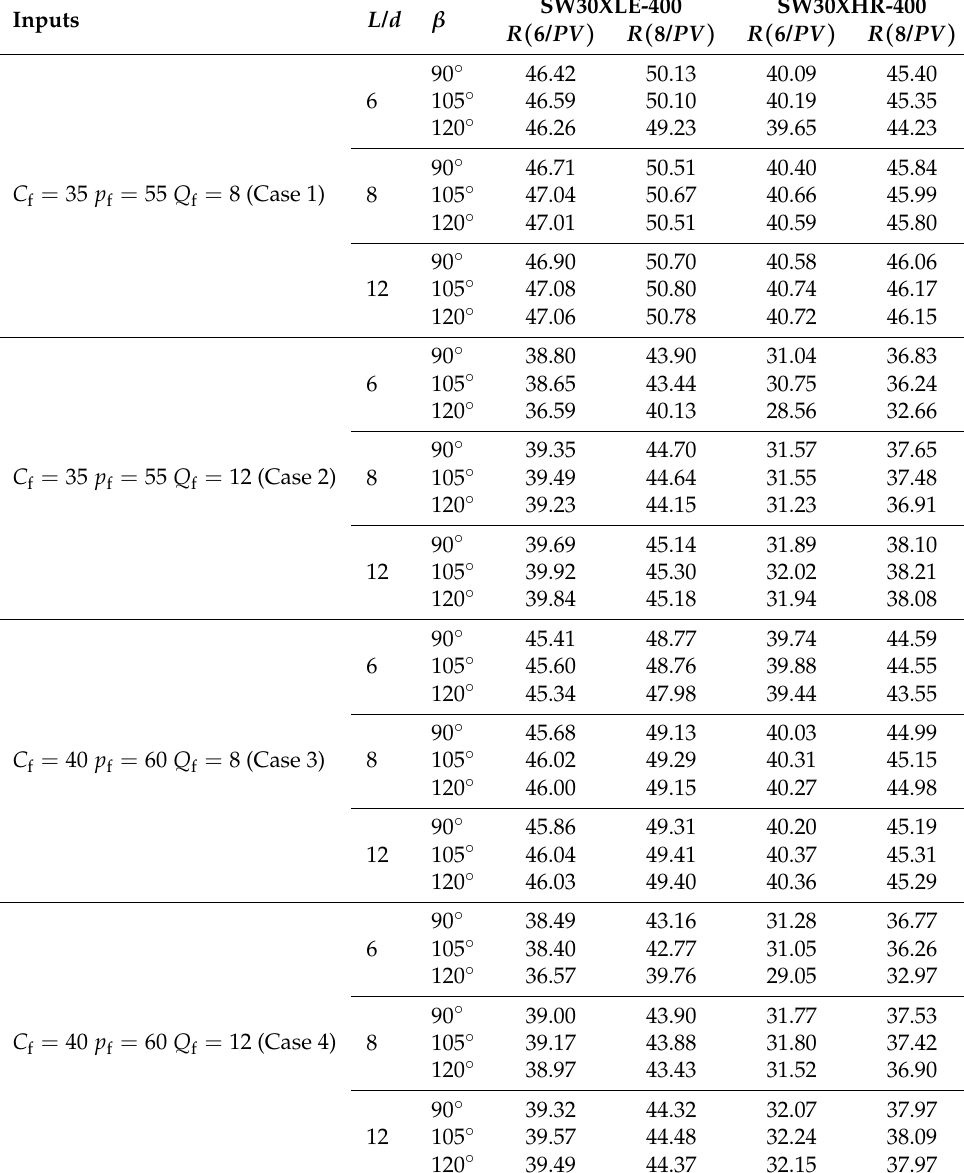
Table 5. R (%) for PVs of 6 and 8 SWMMs with the two membranes studied with different FSGs.